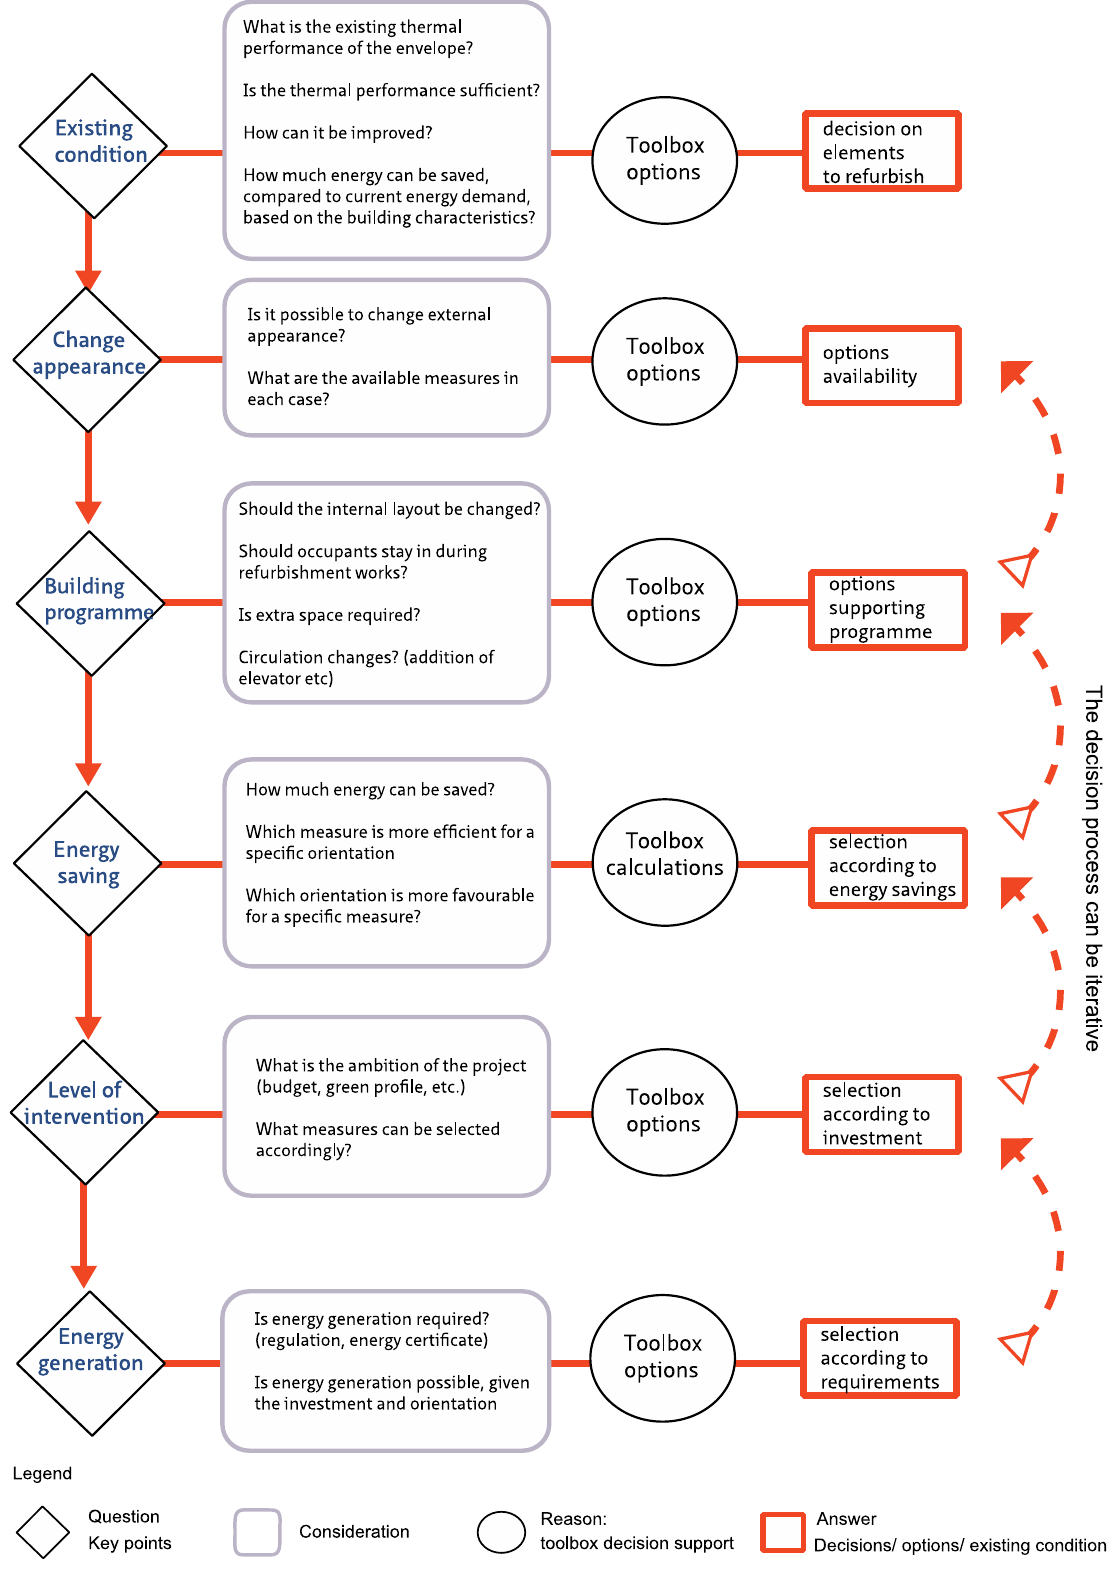
Figure 3. The roadmap to façade refurbishment